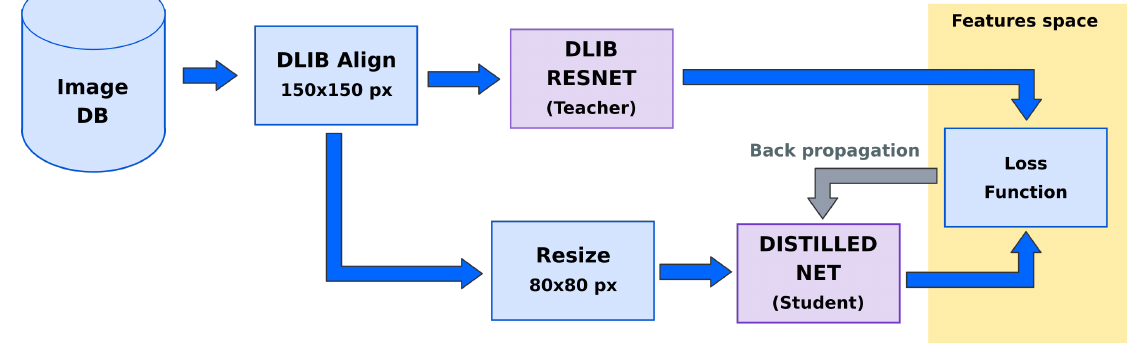
Figure 7. Proposed system with Dlib Resnet as teacher and Distilled network as student.